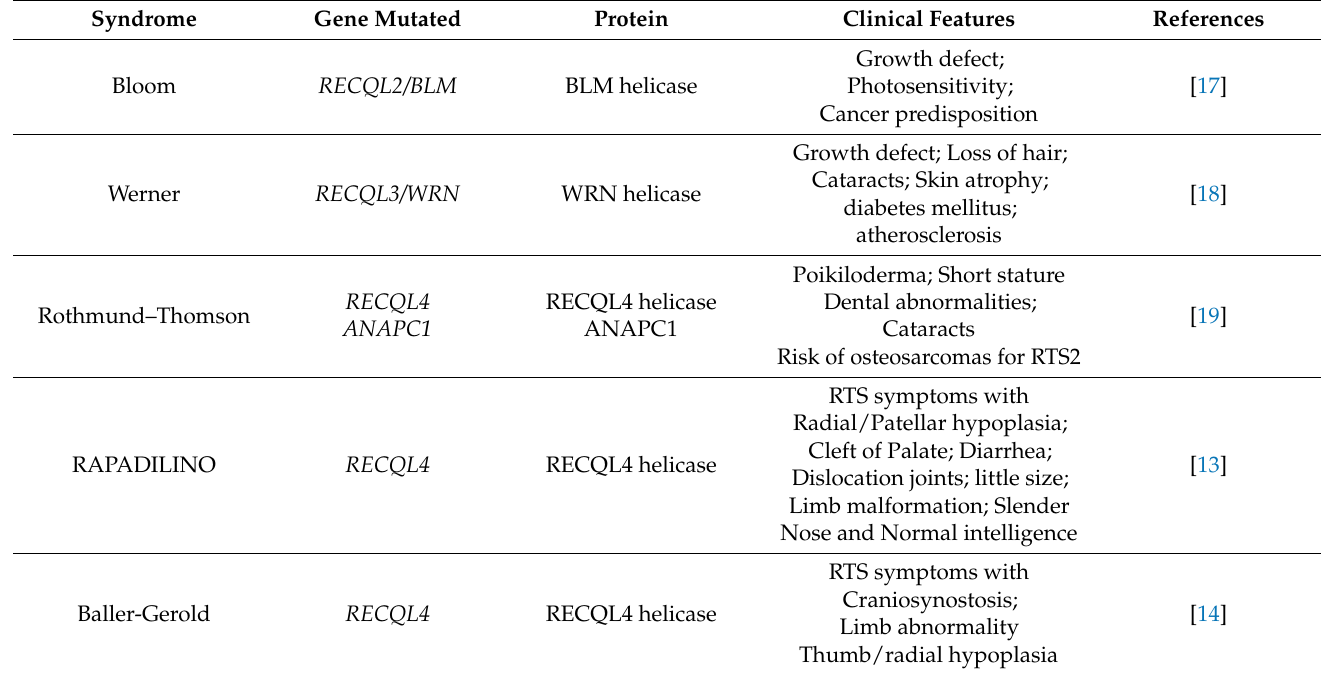
Table 1. The major genetic syndromes caused by mutations of RECQ